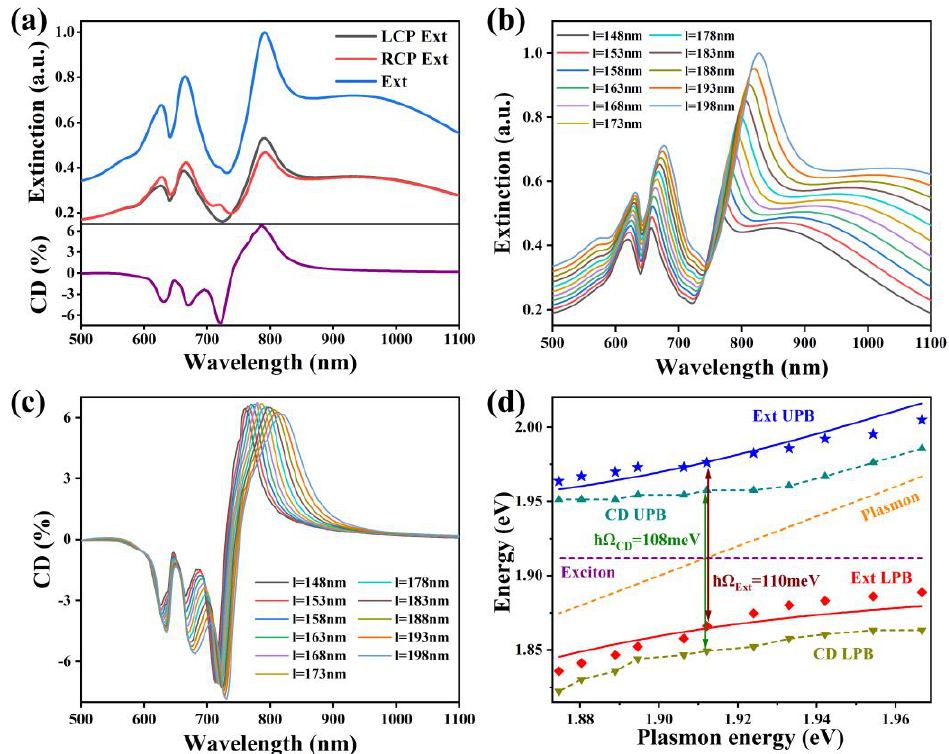
Figure 4. ( a ) The LCP extinction, the RCP extinction, the total extinction, and the CD spectrum of GHNP hybrid system at zero detuning. ( b ) Extinction and ( c ) CD spectra of the vertex mode–excitons strong coupling system with the detuning of side length l . ( d ) Dispersions of the hybrid modes extracted from the simulated extinction (blue stars, red diamonds) and CD (cyan positive triangles, yellow inverted triangles) spectra. The blue and red solid lines are fit results of the extinction data obtained via the COM. Rabi splitting of the anticrossing curves extracted from extinction and CD spectra are 110 meV and 108 meV, respectively. The purple and orange dashed lines represent uncoupled plasmon and exciton energies, respectively.